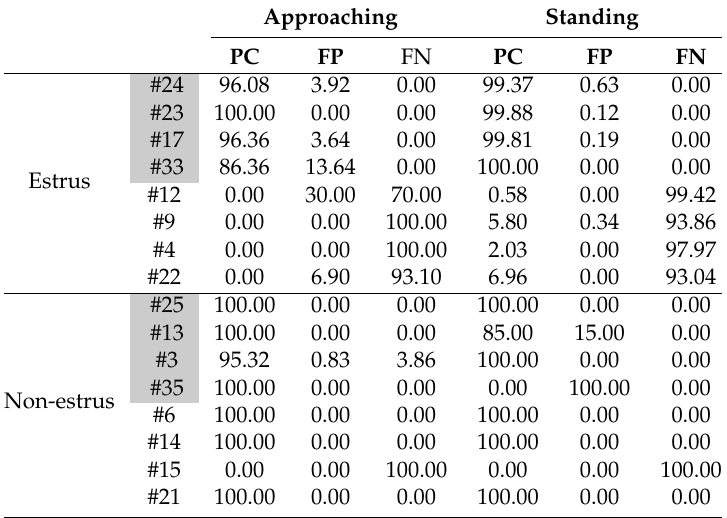
Table 3. PCs, false positives, and false negative of estimation using support vector machines. Gray-colored cells represent goats used for training data.